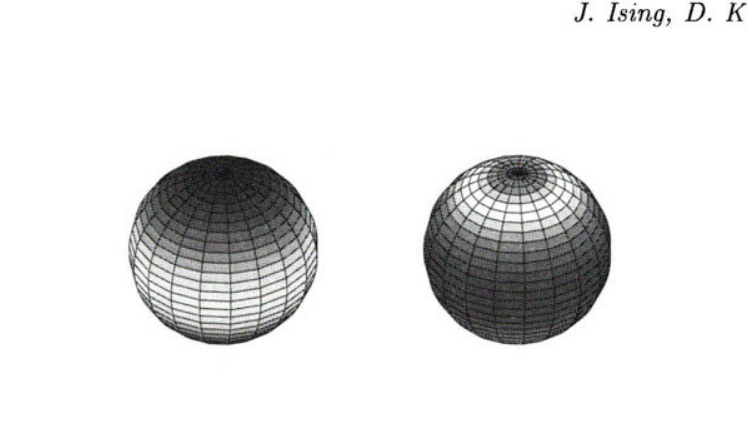
Fig. 5. Surface distribution for a I = 2 mode and 15 % pressure am- plitude in two phases with a time difference of 0.5 periods. The graylevel is the same as in Fig.